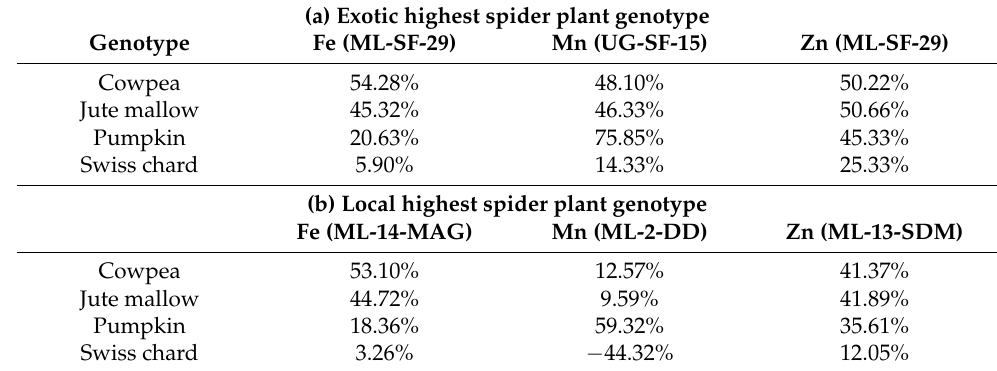
Table 2. Percentage deficit between the highest ( a ) exotic and ( b ) local spider plant genotype and individual standard leafy